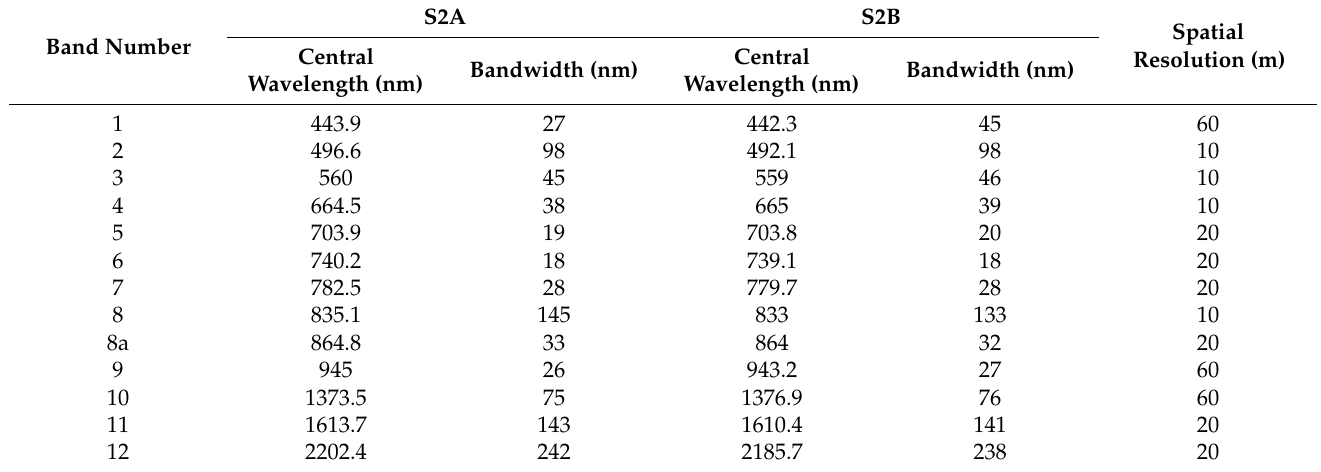
Table 1. Spectral bands for the Sentinel-2 sensors